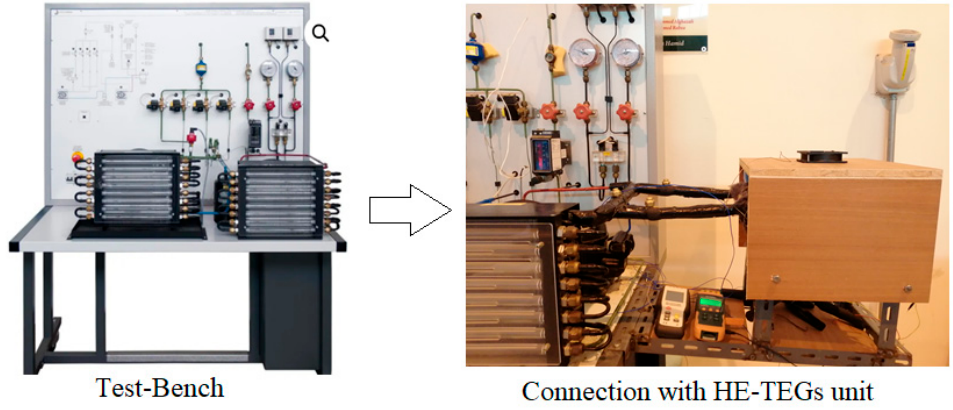
Figure 4. Pictures of experimental set-up and integration of HE-TEGs